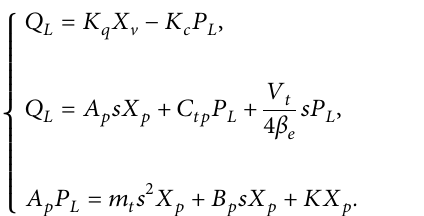
Figure 3: Electro-hydraulic servo control system schematic.